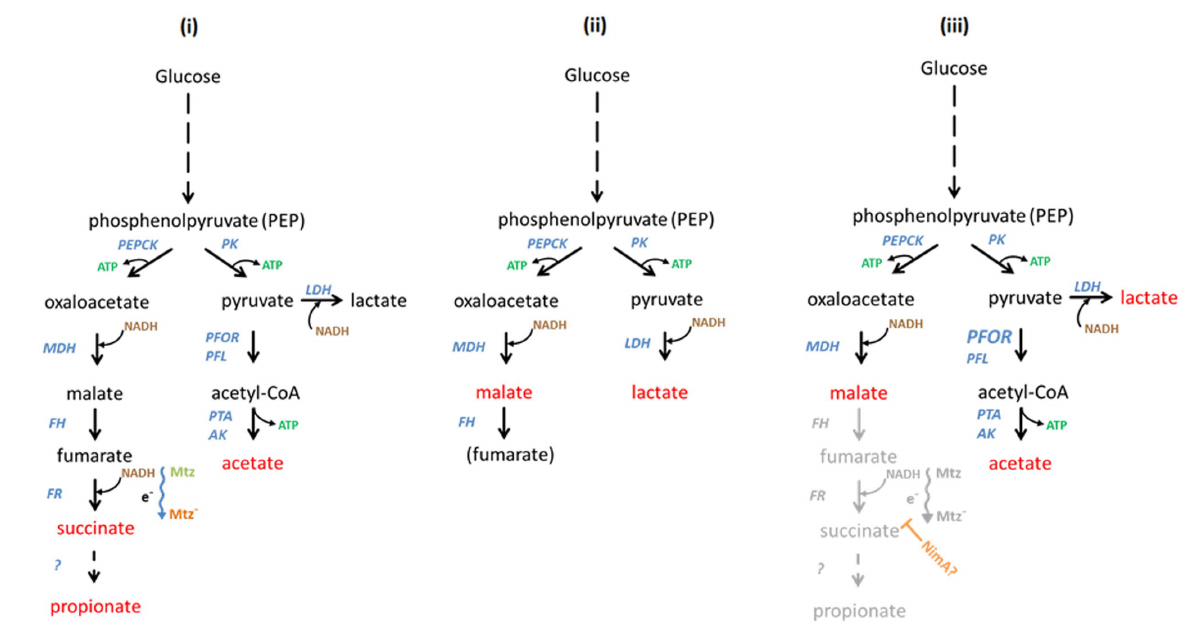
FIGURE 4 Hypothetical scheme of the interdependence of Bacteroides fragilis metabolism, induced metronidazole resistance, and of NimA-mediated protection from metronidazole, respectively. The main metabolic end products are indicated in red, the enzymes involved in blue, ATP in green, and NADH in brown. In the left panel (i) the pathways in B . fragilis leading to the formation of the metabolic end products (Frantz and McCallum, 1979) are depicted. Glucose is broken down to phosphoenolpyruvate (PEP) which can be either converted to oxaloacetate by phosphoenolpyruvate carboxykinase (PEPCK) or to pyruvate by pyruvate kinase (PK). Oxaloacetate is reduced to malate by malate dehydrogenase (MDH). Fumarate hydratase (FH), alternatively termed fumarase, dehydrates malate to fumarate which is then converted by fumarate reductase (FR) to succinate. Finally, succinate is converted to propionate by as yet unknown enzymes. The conversion of fumarate to succinate depends on an electron chain (indicated by e − and a wavy arrow) which might be involved in metronidazole reduction (Mtz to Mtz − ). Importantly, also cytochrome ubiquinol oxidase depends on this electron chain. Pyruvate is converted to acetyl-CoA by pyruvate:ferredoxin oxidoreductase (PFOR) and/or pyruvate formate-lyase (PFL). Ultimately, acetyl-CoA is converted to acetate by phosphotransacetylase (PTA) and acetate kinase (AK). Alternatively, pyruvate can be reduced to lactate by lactate dehydrogenase (LDH). Lactate, however, is not a major end product under normal conditions. In the middle panel (ii) the altered metabolism of 638R R is shown. Due to the lack of iron and/or heme, PFOR and FR are not functional. Further, PFL is strongly downregulated. Consequently, NAD+ must be recycled through the reduction of pyruvate and oxaloacetate, rendering lactate and malate the major metabolic end products. Pathways for the reduction of metronidazole are shut-down. The loss of cytochrome ubiquinol oxidase activity is compensated by upregulation of FprA.